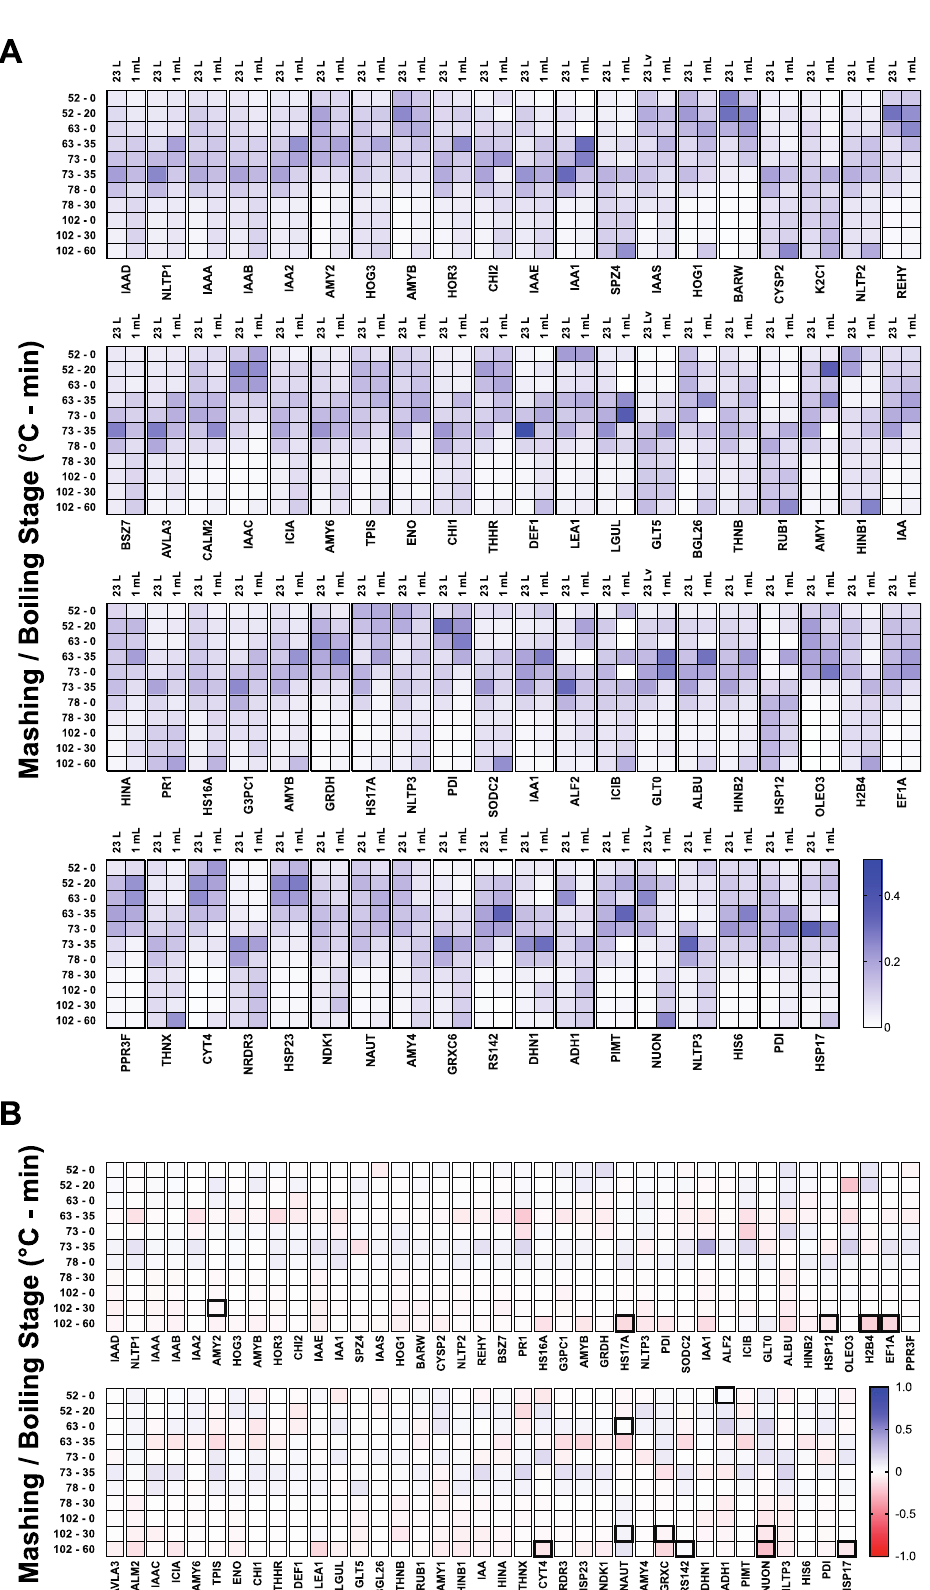
Figure 2. Overall protein abundance profiles are similar between a 23 L Braumeister mash and a 1 mL micro-scale mash. ( A ) Normalised abundance at each time point in 23 L Braumeister and 1 mL micro-scale mashes, for all proteins identified. Relative protein abundance was calculated as protein intensity at each point relative to trypsin intensity at the same point. Normalised abundance was then calculated as the relative protein abundance at each point relative to the combined relative protein abundance across all points. ( B ) Difference of the normalised protein abundance means at each time point between 23 L Braumeister and 1 mL micro-scale mashes. Positive values (blue), higher in 23 L Braumeister; negative values (red), higher in 1 mL micro-scale. Bold highlights, statistically significant ( p <